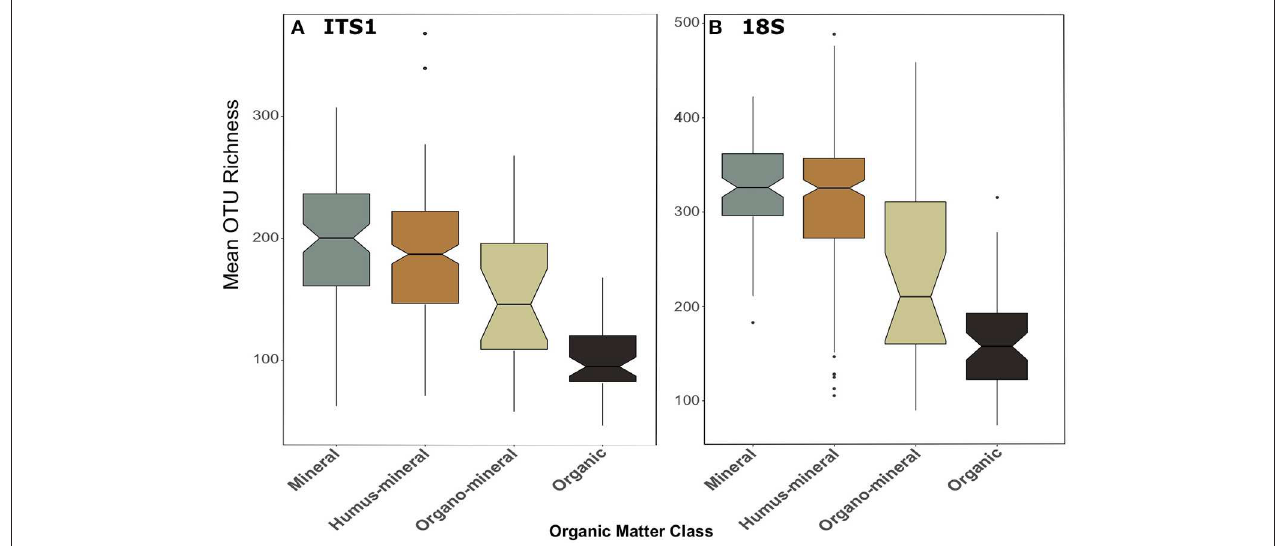
FIGURE 5 | Boxplots of fungal OTU richness for (A) ITS1 and (B) 18S datasets plotted against organic matter class. Organic matter classes are listed in order of increasing percent organic matter. Boxes cover the first and third quartiles and horizontal lines denote the median. Black dots represent outliers beyond the whiskers, which cover 1.5X the interquartile range. Notches indicate confidence interval around the median. Overlapping notches are a proxy for non-significant differences between medians. Black dots are outliers.